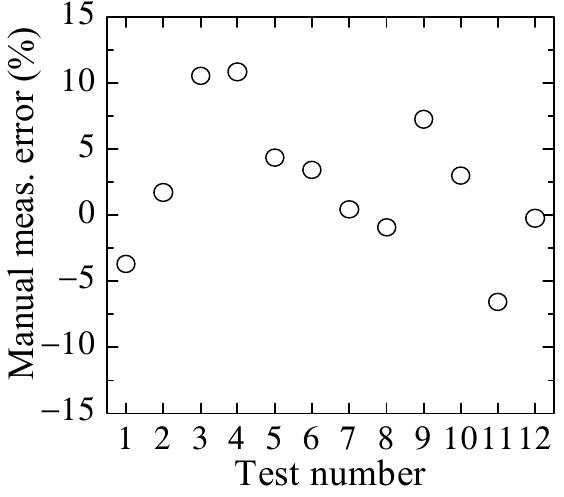
Figure 7. Relative error in repeated tests when using manual timing for the estimation of the walking speed. The relative error is evaluated with reference to the objective and accurate timing obtained from two photocell barriers set 4 m apart along the walk path.